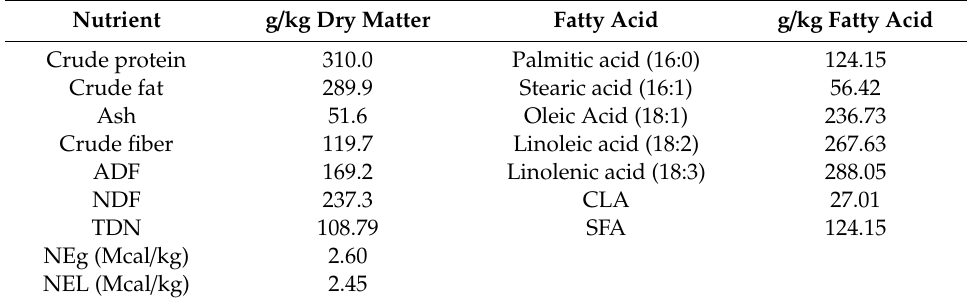
Table 3. Nutrient and fatty acid concentrations in the extruded linseed and soybean